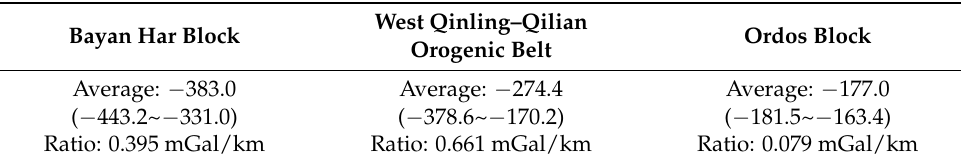
Table 1. Bouguer gravity anomaly features of different parts of the Barkam–Jiuzhaigou–Wuqi profile (Unit: